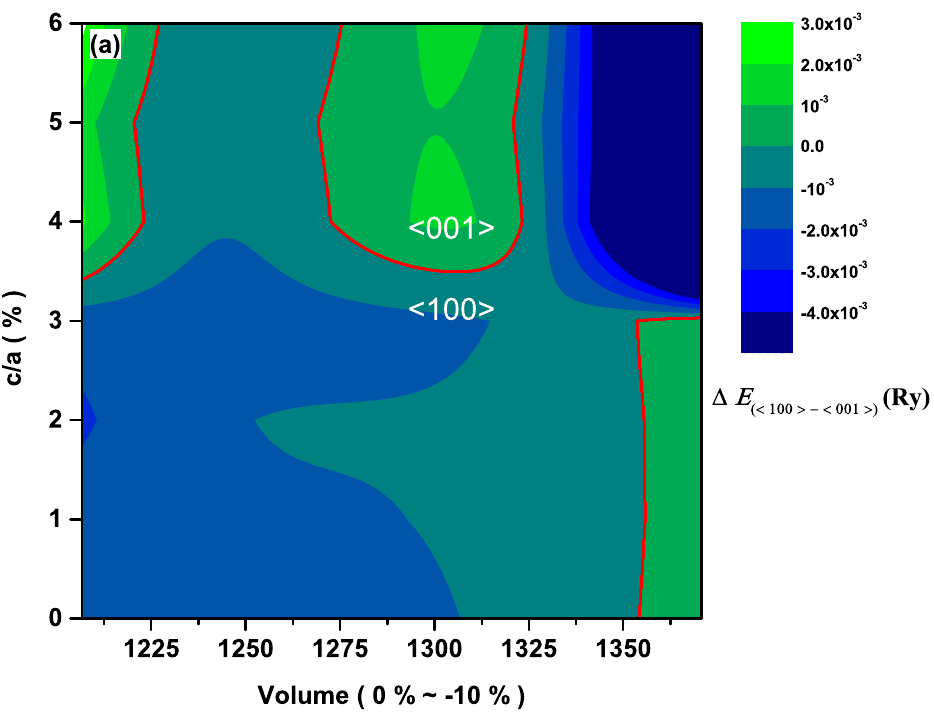
− E 001 tot tot , for the CeAuSb 2 compound. The thick red